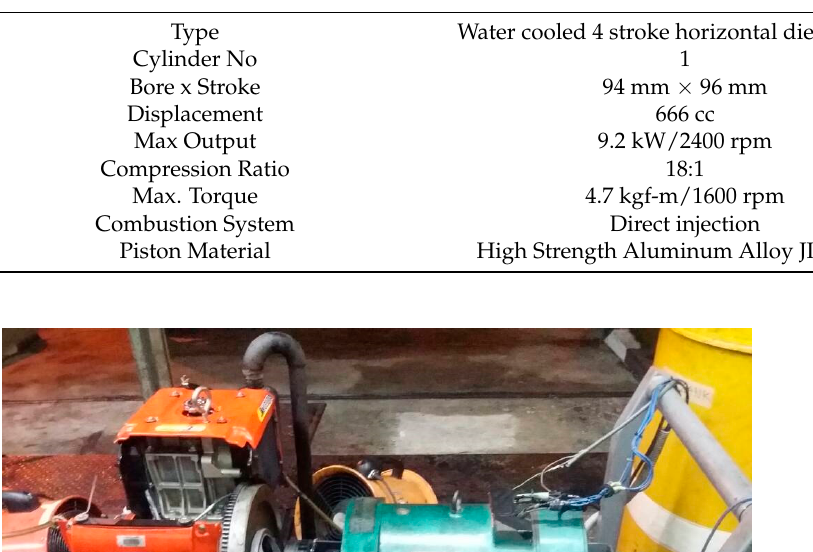
Figure 2. Kubota RT-125 diesel engine experimental setup.